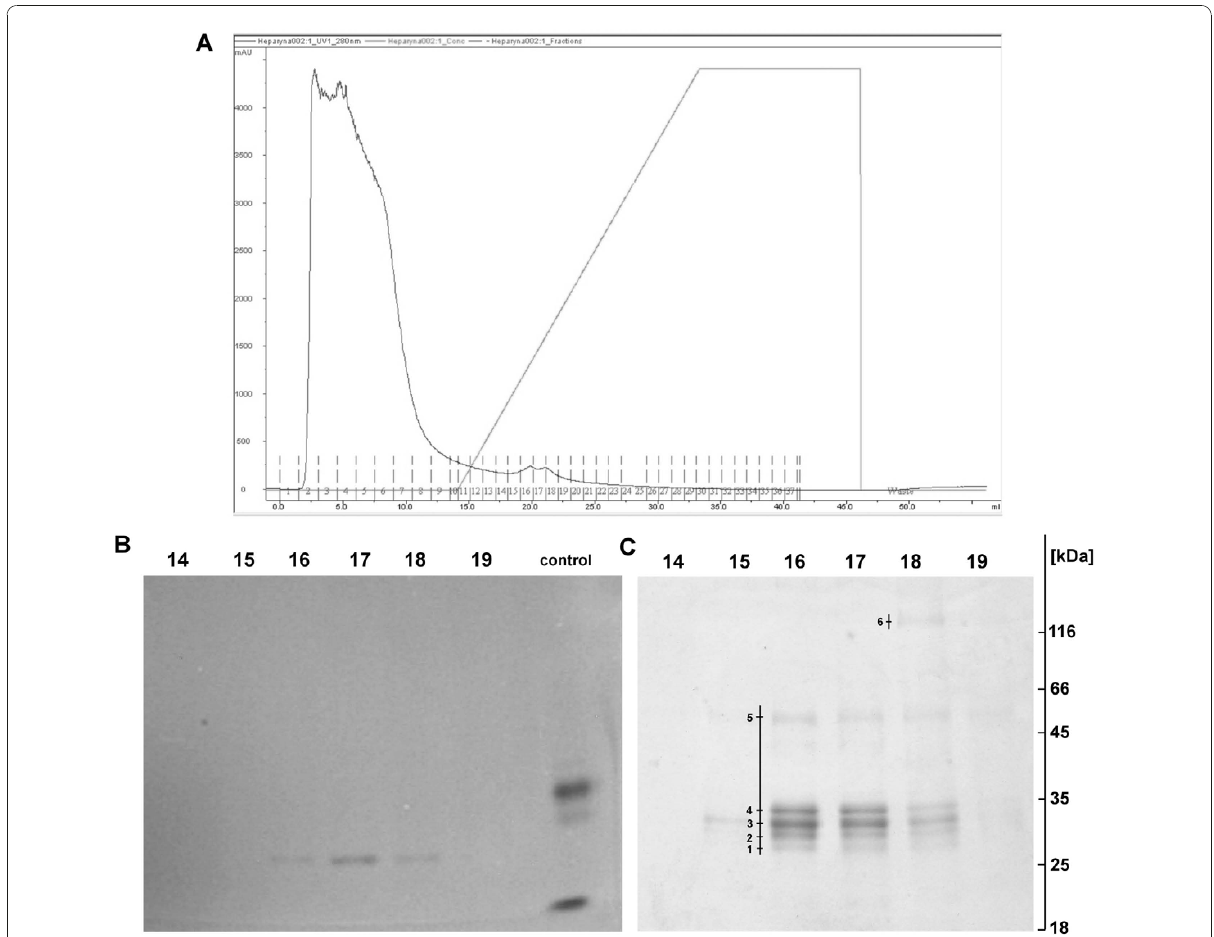
Figure 1 Protein purification and electrophoretic analysis . (A) Chromatographic profile of protein purification from C. cava tuber extracts in HT Heparin column (GE Healthcare). Fractions 1 to 9 represented flow-through fractions, 10 to 27 were eluted with a linear NaCl gradient (from 0 to 2 M). The absorbance of all fractions was measured at 280 nm and their DNase activity was estimated using in-gel assay. Proteins present in fractions 16, 17 and 18 were identified using LC-ESI-MS/MS. Fractions 16-19 following three rounds of purification were used in tests on HeLa tumour cell line. (B) In-gel DNase pattern of the gel in which DNase activity of protein fractions originating from C. cava tuber extracts was estimated. ssDNA containing 10% SDS-PAGE, following electrophoresis and incubation (12 h) in 10 mM Ca 2+ buffer, pH 8.0, was stained with ethidium bromide and viewed under UV light. Nucleolytic activity was noted in fractions Nos.16, 17 and 18 of MW around 30 kDa. Control: purified nucleases from Chelidonium majus milky sap served as positive control. (C) 10% SDS-PAGE following electrophoresis of fraction- contained proteins and silver staining according to Shevchenko et al. [20]. The separated fractions were identical to those in the gel in Fig. 1B. Fractions nos. 16 and 17 each contained 5 protein bands of MW around 30, 32, 35, 38 and 68 kDa, while fraction no. 18 contained an additional band of MW around 140 kDa. The protein bands were numbered 1-6, excised from the gel and sent for identification by mass spectrometry (LC- ESI-MS/MS). M - Protein Molecular Weight Marker